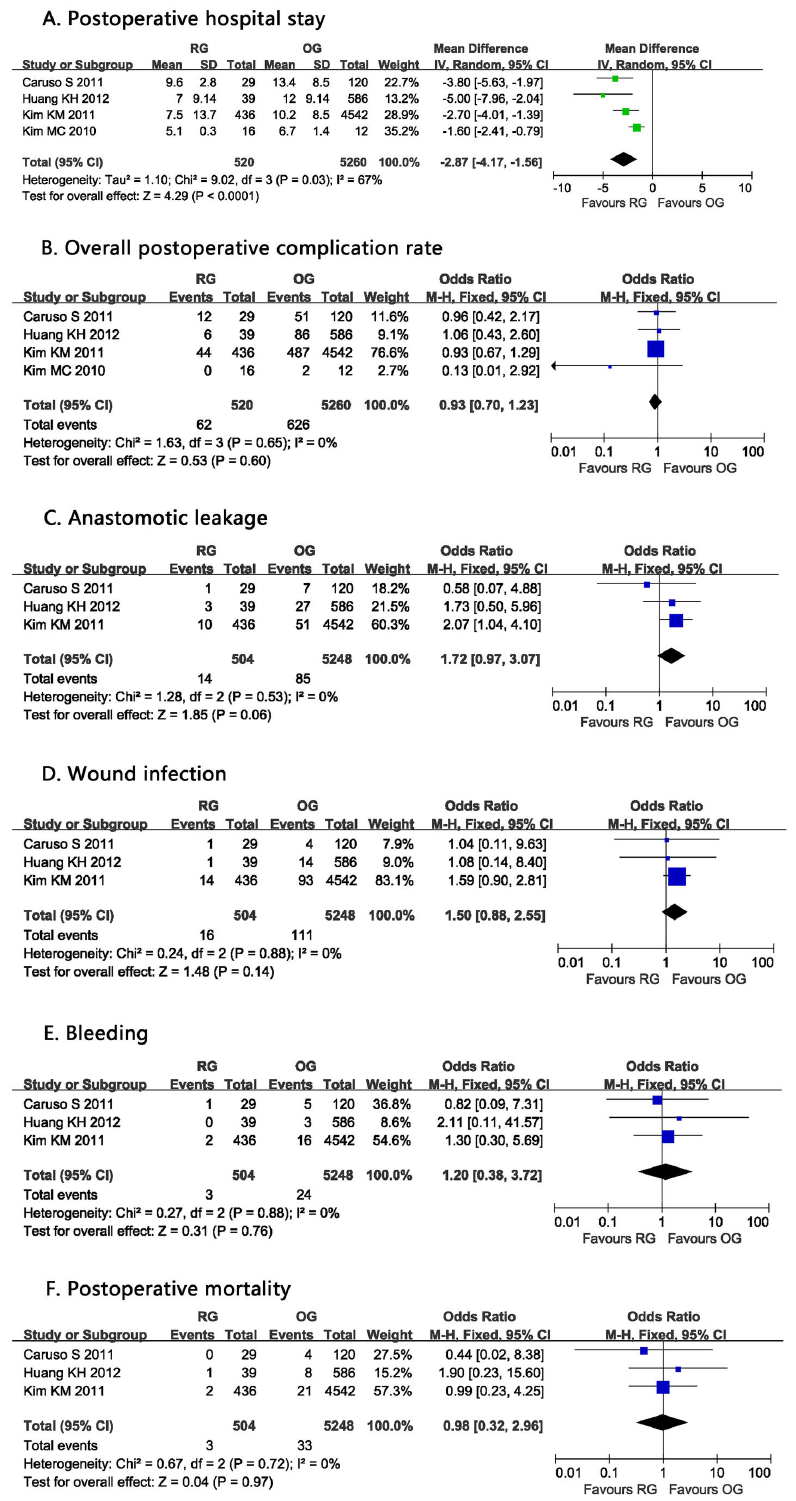
Figure 3. Forest plot showing a meta-analysis for robotic gastrectomy versus open gastrectomy on A. Postoperative hospital stay; B. Overall postoperative complication rate; C. Anastomotic leakage; D. Wound infection; E. Bleeding; F. Postoperative mortality.